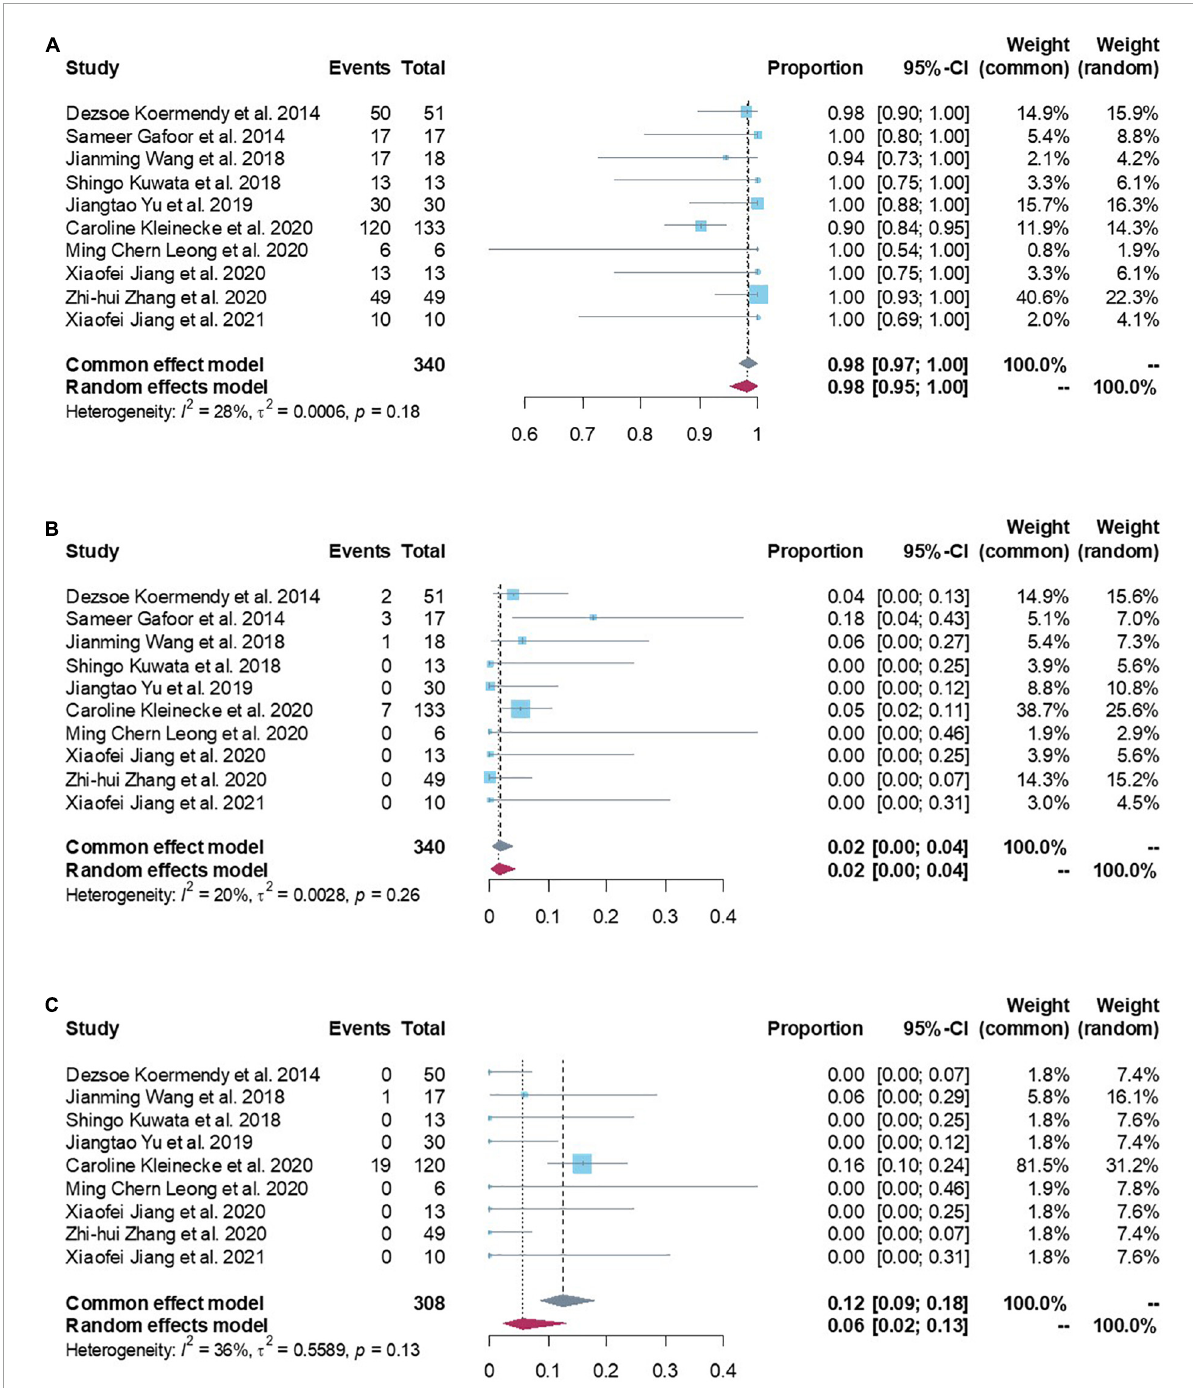
FIGURE2 (A) Forest plots of procedural feasibility outcome (procedural success proportion). (B) Forest plots of procedural safety outcome (death/device embolization/cardiac tamponade/major bleeding/stroke/major access vessel complication/other). (C) Forest plots of procedural efficacy outcome (all-cause stroke/systemic embolism/cardiovascular and unexplained